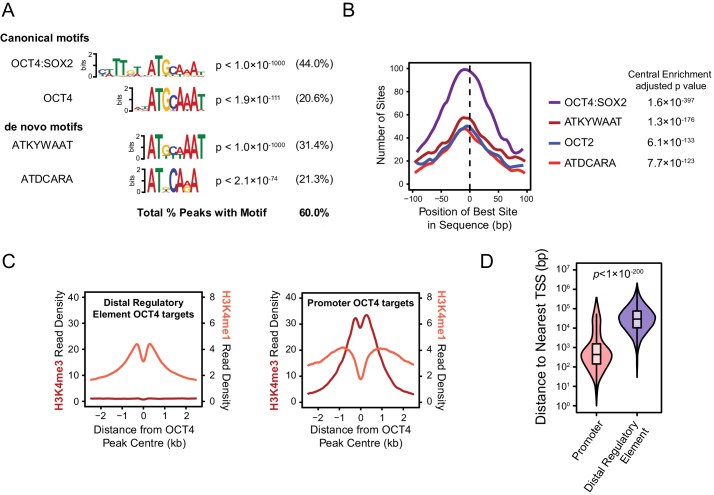
Annotation and characterisation of OCT4 binding sites in OCT4cond ESCs.(A) Motif enrichment analysis for canonical motif sequences (top) or de novo motif sequences (bottom) reveals high enrichment for OCT4 (POU5F1) and similar motif sequences in the OCT4cond OCT4 binding sites (n = 15920). % reflects the percentage of OCT4 peaks identified to contain each motif sequence. (B) Central enrichment analysis performed by CentriMO reveals that canonical and de novo OCT4 motifs are centrally enriched at OCT4 peak intervals. (C) A metaplot of H3K4me1 and H3K4me3 at OCT4 binding sites annotated as distal regulatory elements or promoters. (D) A violin plot comparing the distance from OCT4 binding sites annotated as distal regulatory elements or promoters to nearest refGene TSS. p denotes significance value by Wilcoxon ranked-sign test.